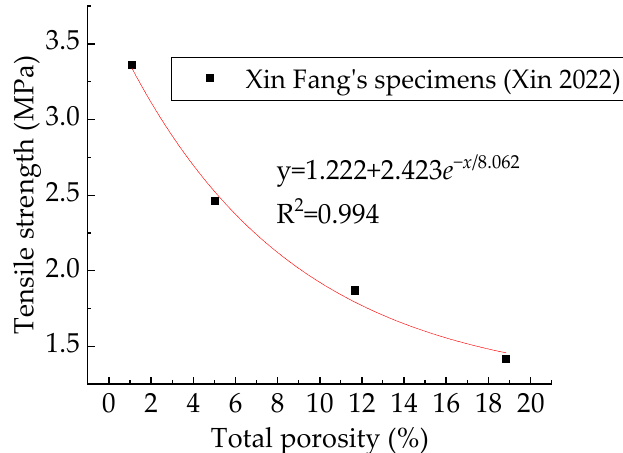
Figure 19. Relationship between the total porosity and the tensile strength.